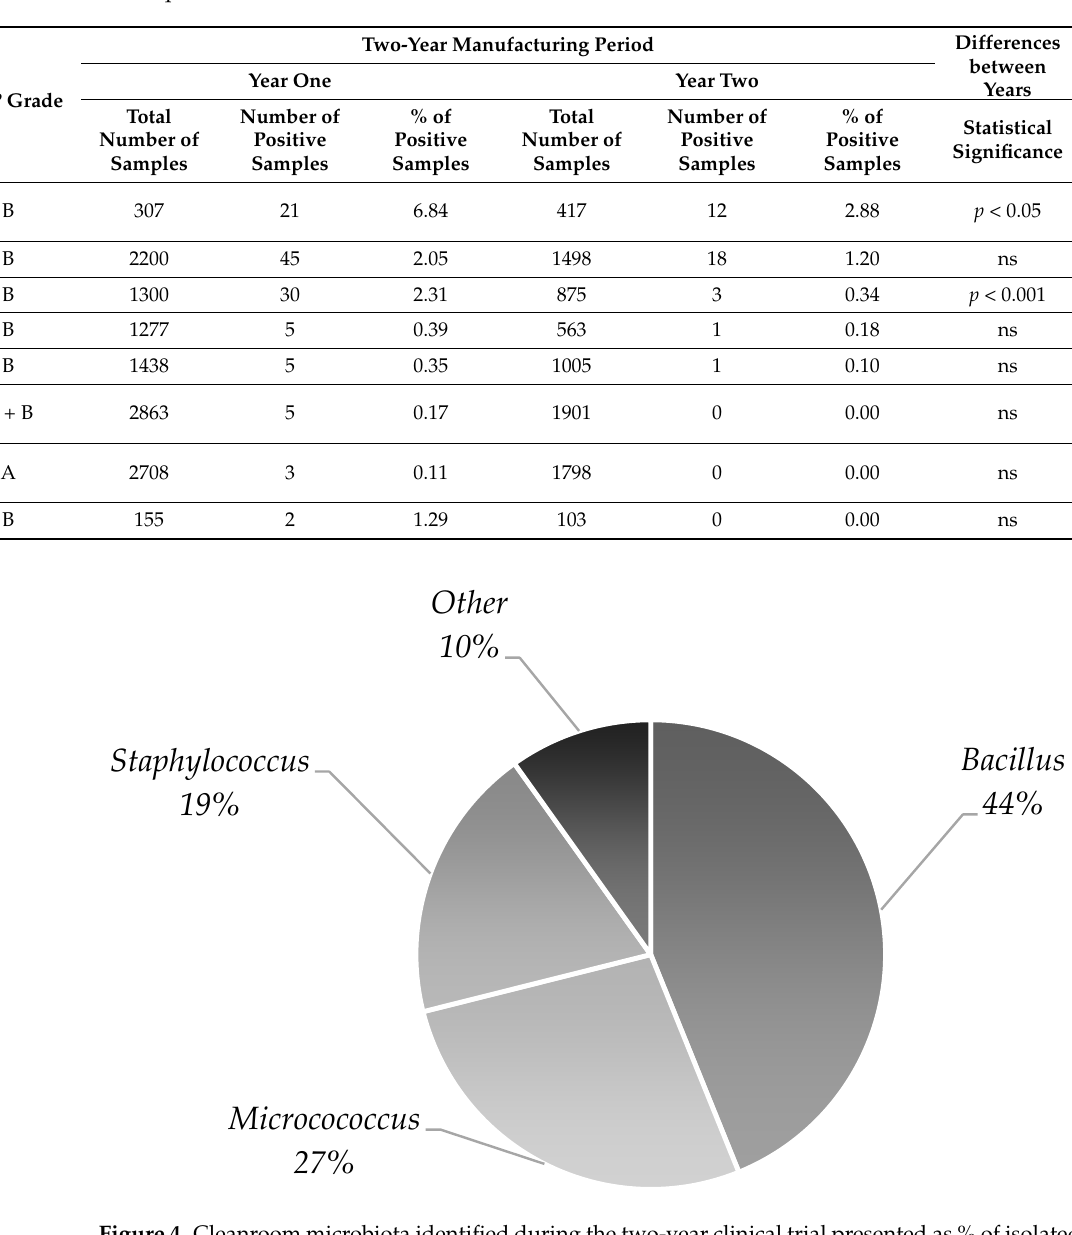
Table 4. Data of positive samples from Grade A and B areas taken with different sampling methods. Statistically significant differences in the frequency of contamination in individual years are marked with square brackets.